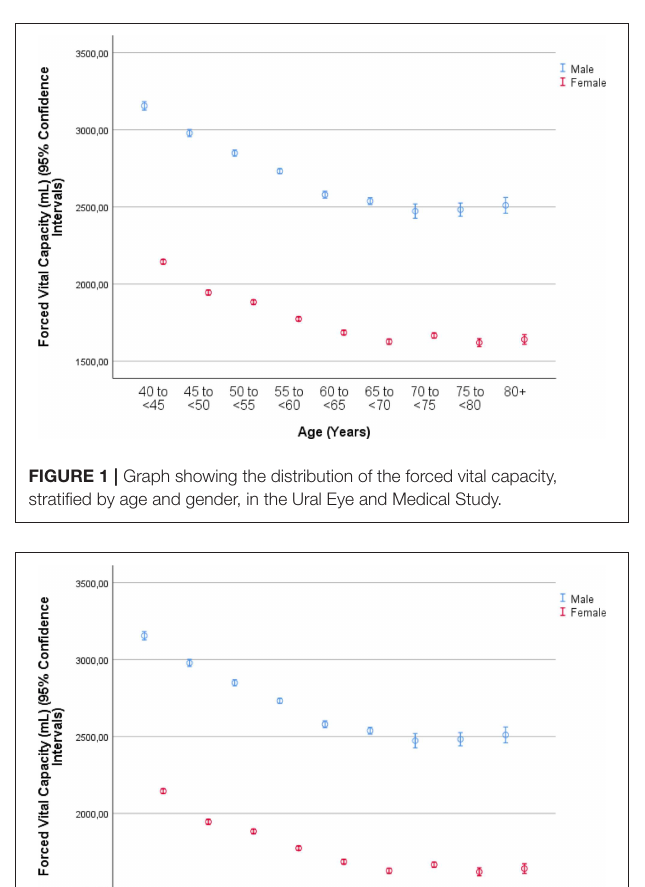
well-remembered. The prevalence of undiagnosed airflow obstruction was 135/5,158 or 2.6% (95%CI: 2.2, 3.1): 4.8%